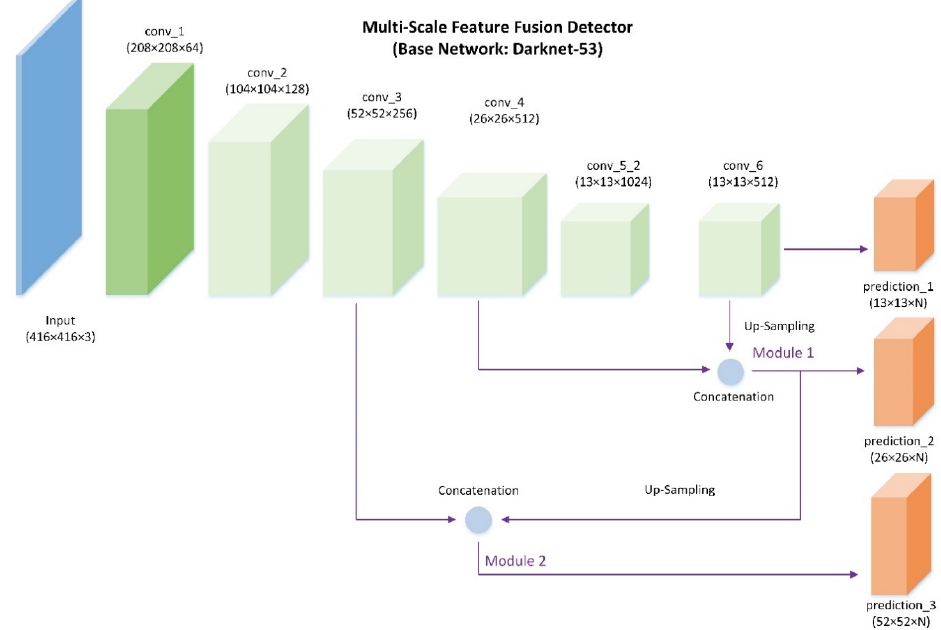
Figure 4. Multi-scale feature fusion detector. Darknet-53 is the base feature extractor. Three predictions are generated at three different scales.